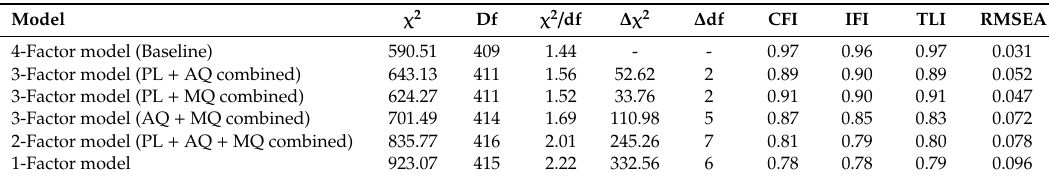
Table 3. Confirmatory Factor Analysis